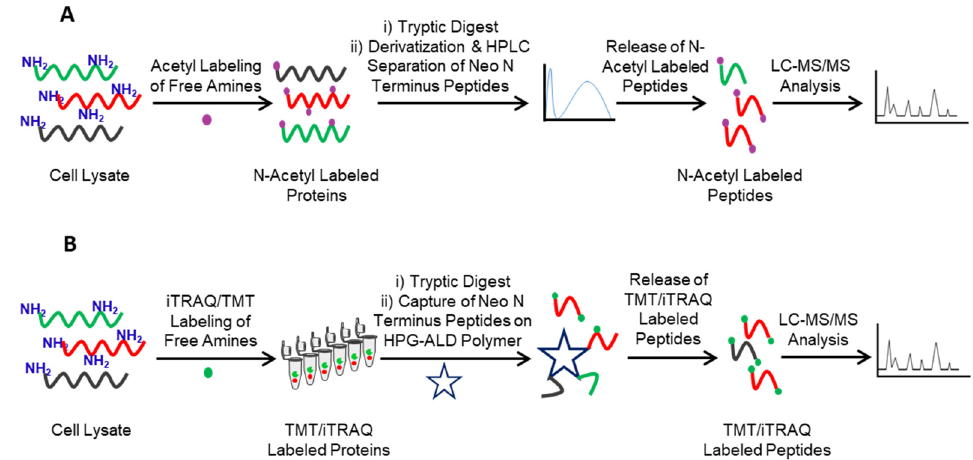
Figure 3. Negative enrichment approaches of N-terminomics. ( A ) In COFRADIC, the native or neo-N-terminal peptides are blocked by acetylation followed by tryptic digest. The internal tryptic peptides are then labeled and separated by HPLC, leaving acetyl-labeled native or neo-N-terminal peptides. LC-MS/MS analysis of acetyl-labeled native and neo-N-terminal peptides provide identity of protease substrates and protease cleavage sites. ( B ) In TAILS, the native or neo-N-terminal peptides are blocked with isobaric labeling followed by trypsin digestion. The internal tryptic peptides are then separated by capturing HPG-ALD polymer, leaving isobaric tag labeled native and neo-N-terminal peptides. LC-MS/MS analysis of probe-labeled native and neo-N-terminal peptides provide identity of protease substrates and protease cleavage sites.